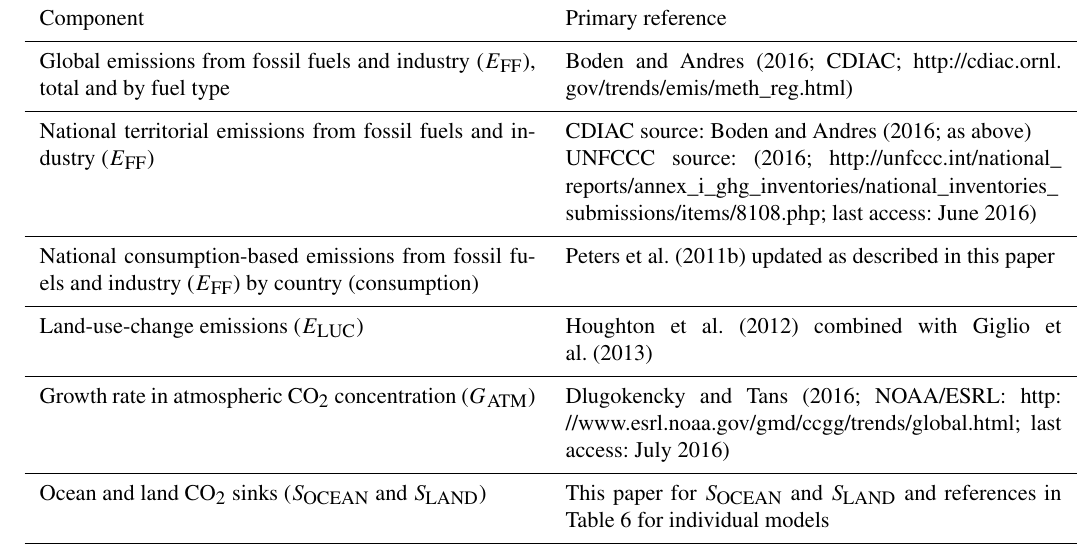
Boden and Andres (2016; CDIAC; http://cdiac.ornl. gov/trends/emis/meth_reg.html) CDIAC source: Boden and Andres (2016; as above) UNFCCC source: (2016; http://unfccc.int/national_ submissions/items/8108.php; last access: June 2016) Peters et al. (2011b) updated as described in this paper